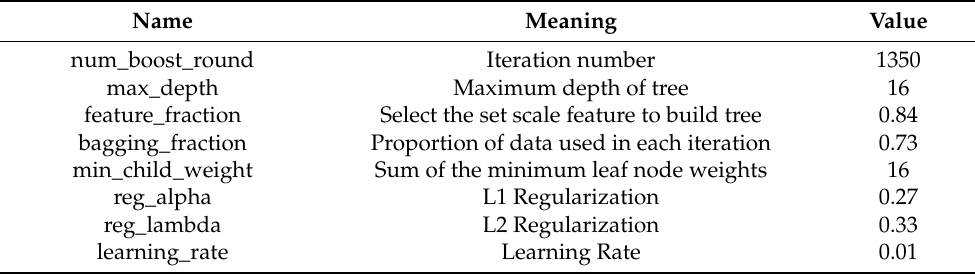
Table 3. Optimal hyperparameters of the LightGBM